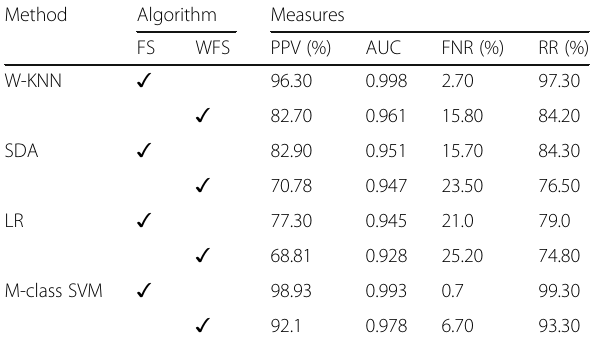
Table 10 Recognition results on KTH dataset Method